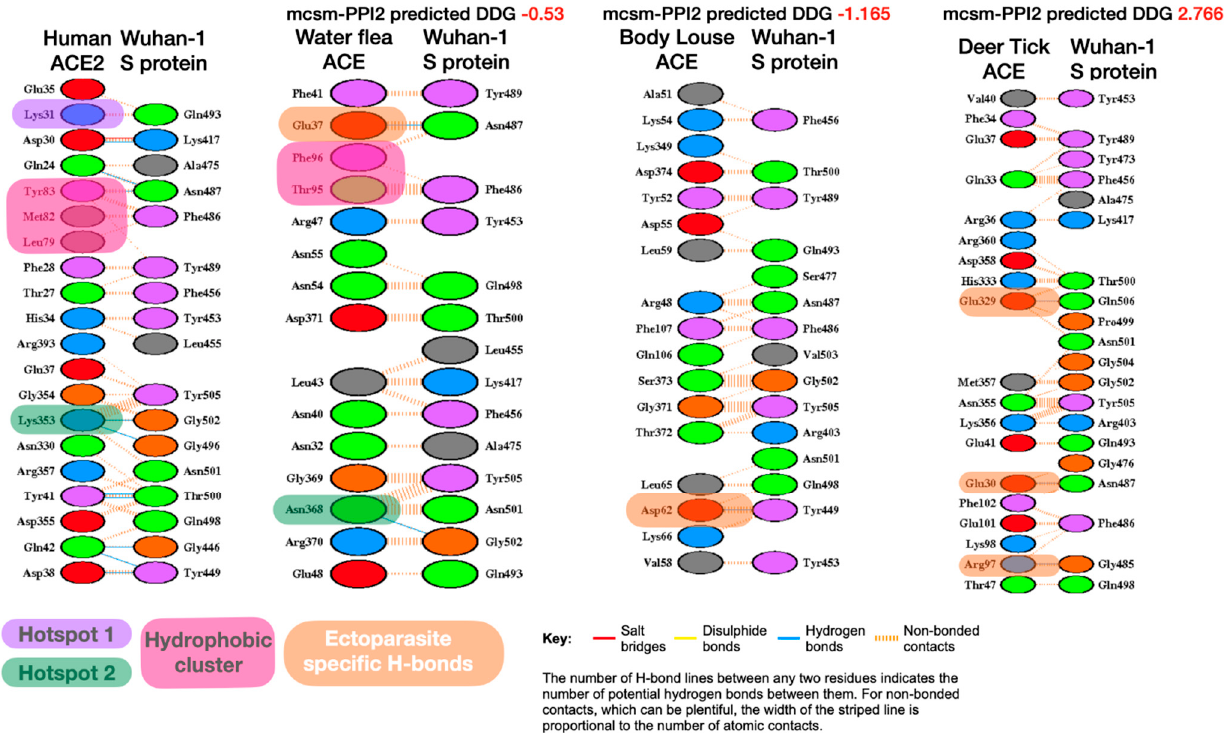
Figure 1. Comparison of LigPlot predicted bonding interactions for Wuhan-Hu-1 strain with human, water flea, body louse and deer tick. Corresponding residues in each species with key human interface hotspots (Hotspot 1, Hotspot 2) and the hydrophobic pocket are indicated if they are predicted to be involved in interface interactions. Novel ectoparasite H-bond residues also shown (pale orange boxes).